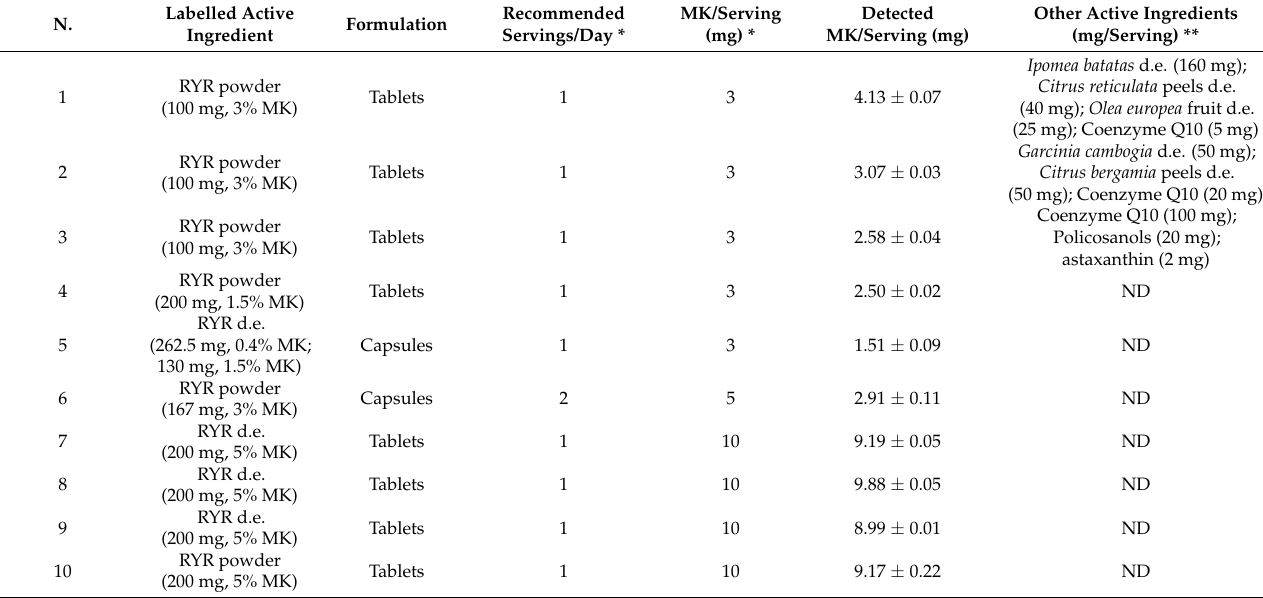
Table 1. Amounts of active ingredients, pharmaceutical forms and labelled information of food supplements containing red yeast rice as the main active ingredient. Detected MK amounts are reported as mean mg/serving ± SD.